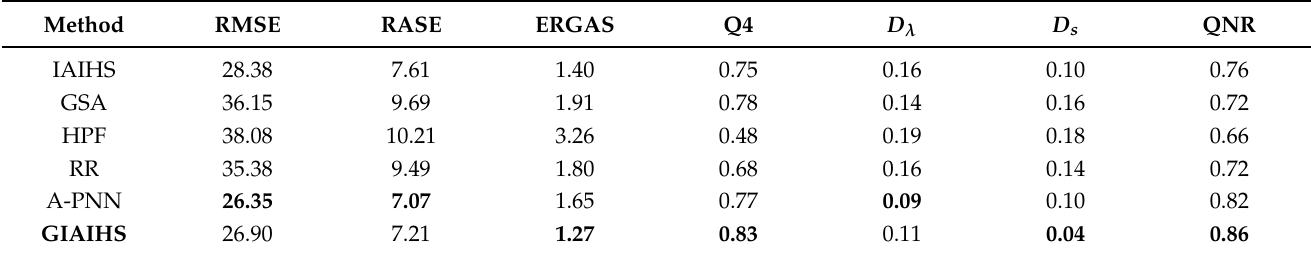
Table 3. Experiment with six PS methods on WorldView-4 satellite